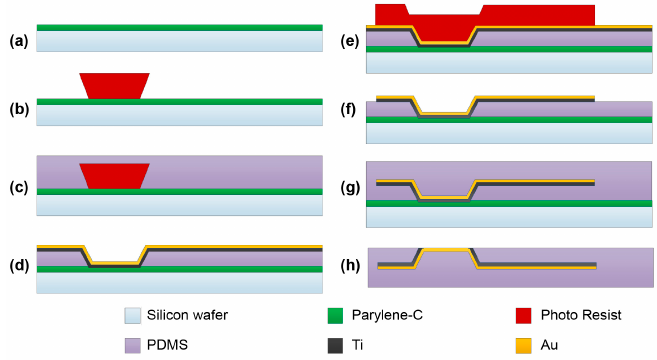
Figure 2. Schematic of fabrication process for a PDMS-based plateau electrode array.